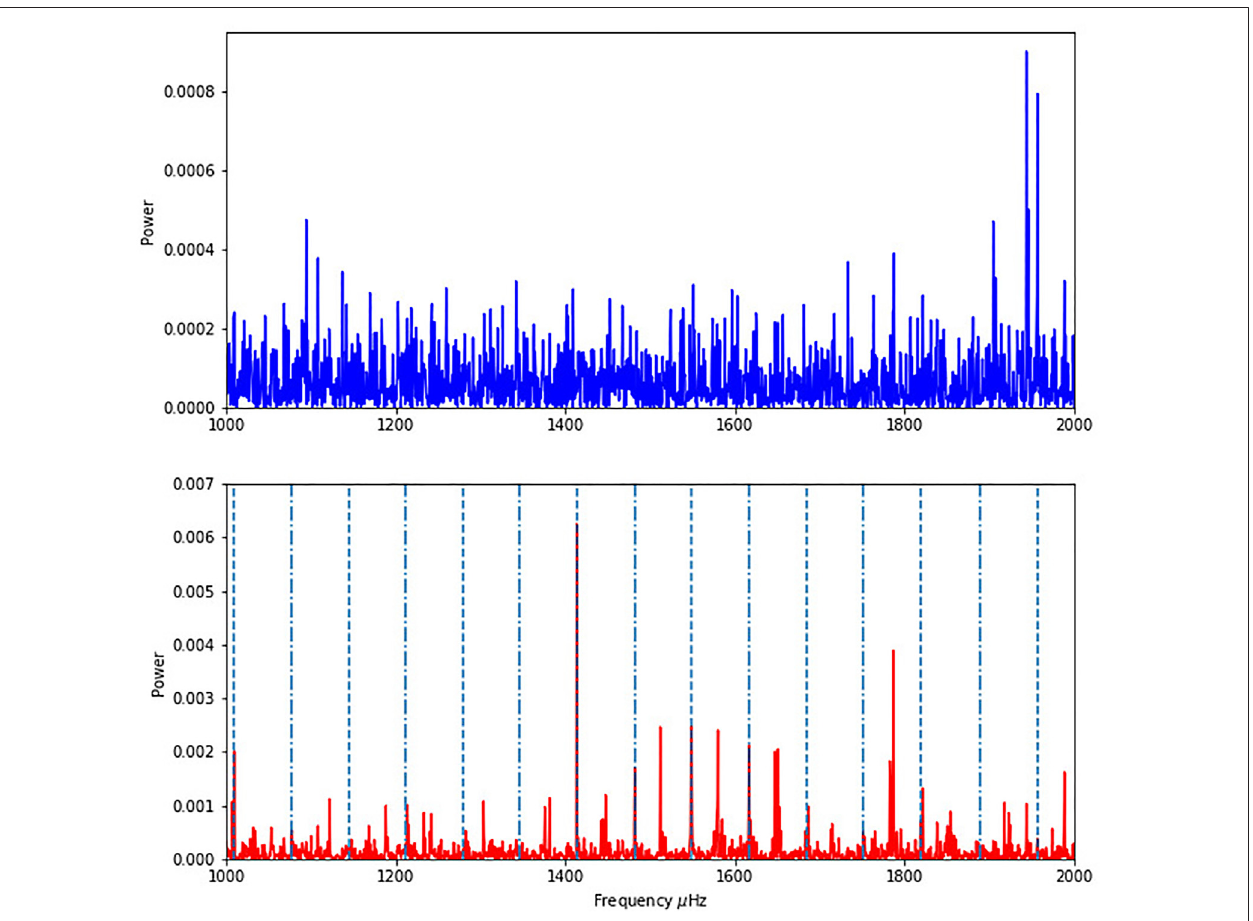
FIGURE 2 | Modi fi ed (red) and Classical (blue) Fourier Transforms of the SoHO data obtained during 16 days, at the region between 1,000 and 2,000 μ Hz . In the red plotweincludethel=0(dashed) andl=1(point-dashed)modes wehaveidenti fi edfromtheanalysisofthenewquaterniontransform.TheGaussianenvelopeofthe structure visible in the red plot could be a hint of the presence of not identi fi ed modes in the common Fourier analysis but further analysis is required to con fi rm this.